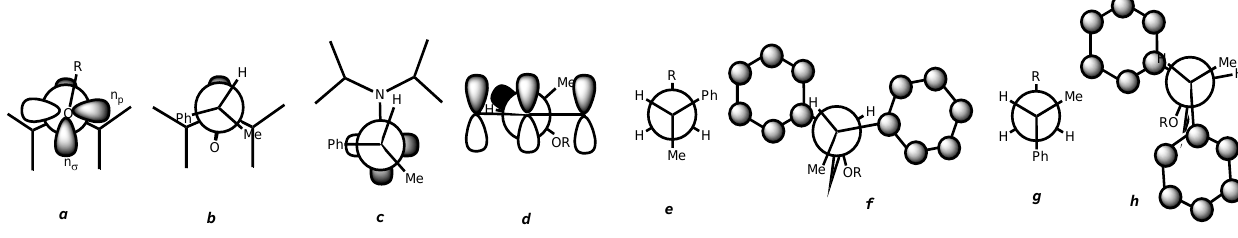
Figure 3. Newman projections given by the torsion angles  gathered in Table 1.